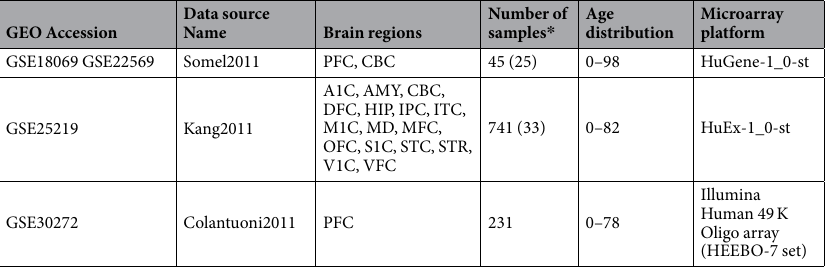
Table 1. Datasets used in the study. The brain region abbreviations stand for: A1C: Primary Auditory Cortex; AMY: Amygdala; CBC: Cerebellar Cortex; DFC: Dorsolateral Prefrontal Cortex; HIP: Hippocampus; IPC: Posterior Inferior Parietal Cortex; ITC: Inferior Temporal Cortex; M1C: Primary Motor Cortex; MD: Mediodorsal Nucleus of the Thalamus; MFC: Medial Prefrontal Cortex; OFC: Orbital Prefrontal Cortex; PFC: Prefrontal Cortex; S1C: Primary Somatosensory Cortex; STC: Superior Temporal Cortex; STR: Striatum; V1C: Primary Visual Cortex; VFC: Ventrolateral Prefrontal Cortex. * Numbers in the parentheses show the number of individuals used in the